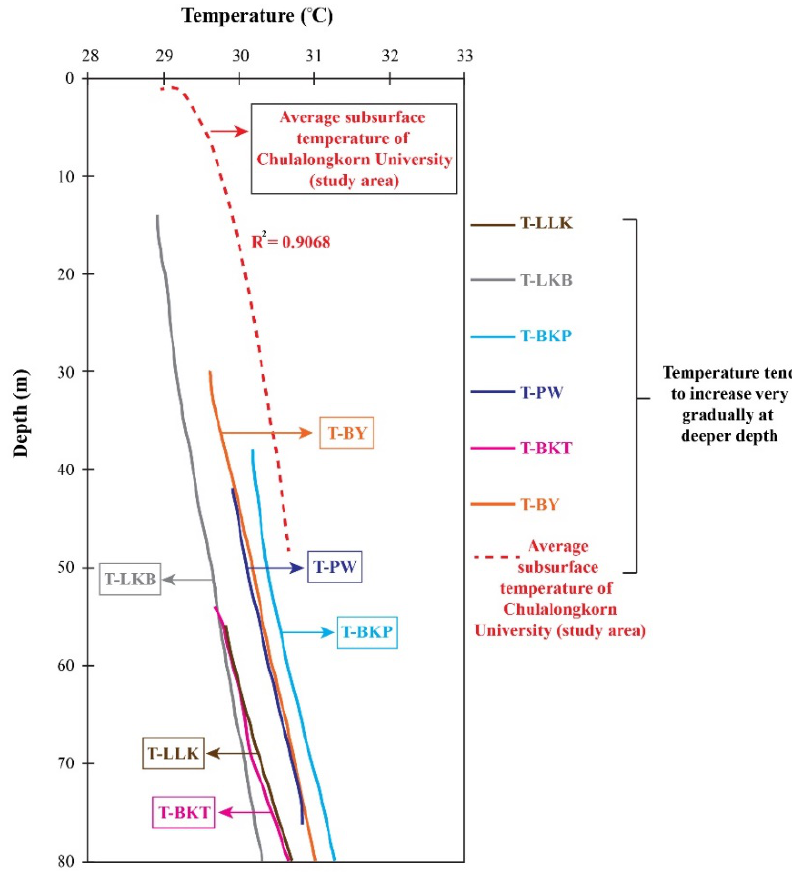
Figure 3. Comparison between well temperature profiles around Bangkok including the study area (data from Uchida et al. [18]).